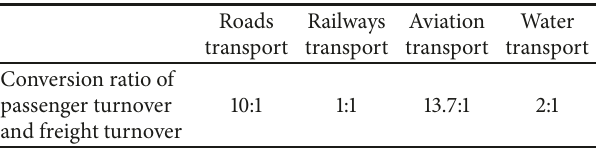
Table 7: Conversion ratio of passenger turnover and freight